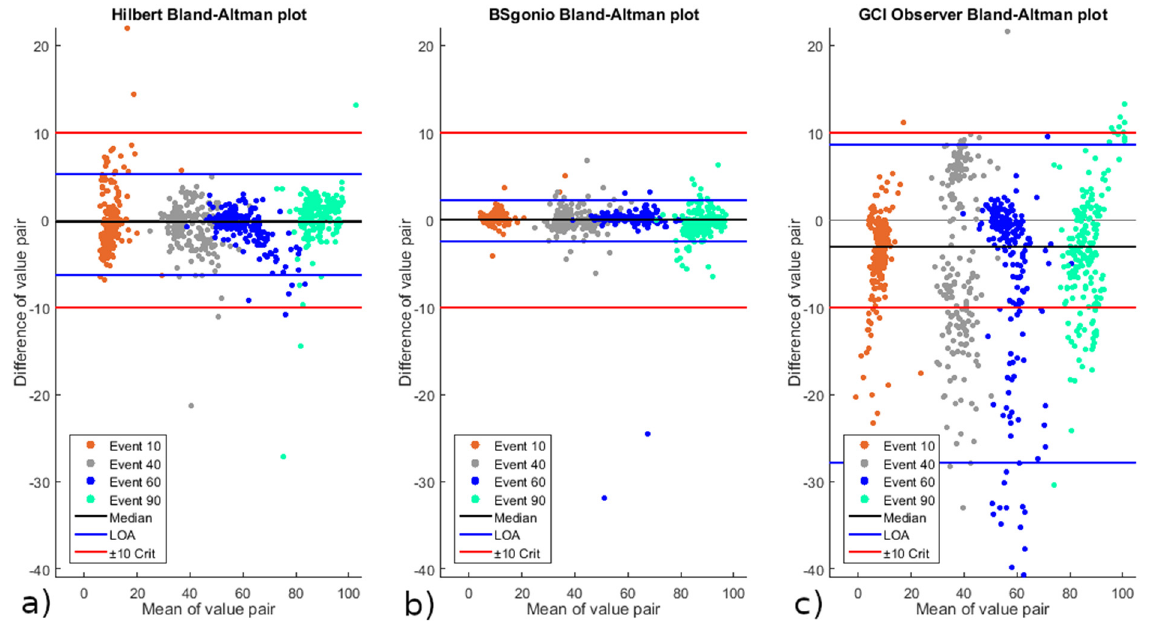
Figure 4. Non-parametric Bland–Altman results for the three algorithms. Presented from left to right, respectively: ( a )